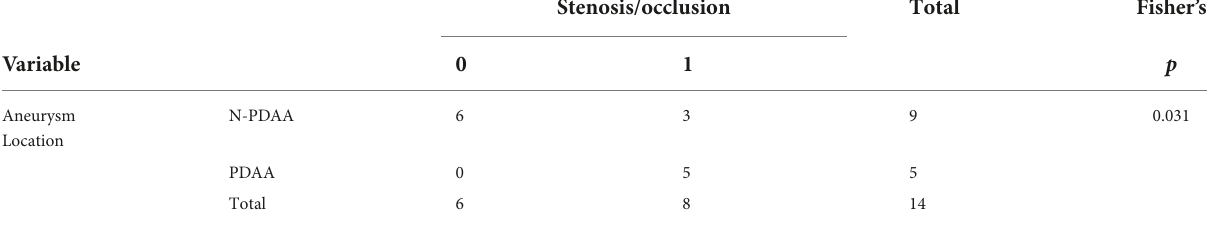
Stenosis/occlusion